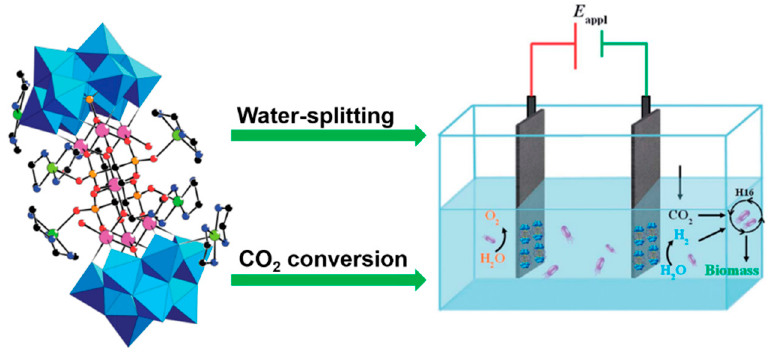
Figure 15. Schematic illustrations of the bioelectrochemical system for CO 2 fixation. Color code: WO 6 octahedra, light blue; Co, pink ball; P, orange ball; Cu spheres, green; C, black ball; N, dark blue ball; O, red ball; H atoms have been omitted for clarity. Reprinted with permission from [67]. Copyright © 2018 The Royal Society of Chemistry.